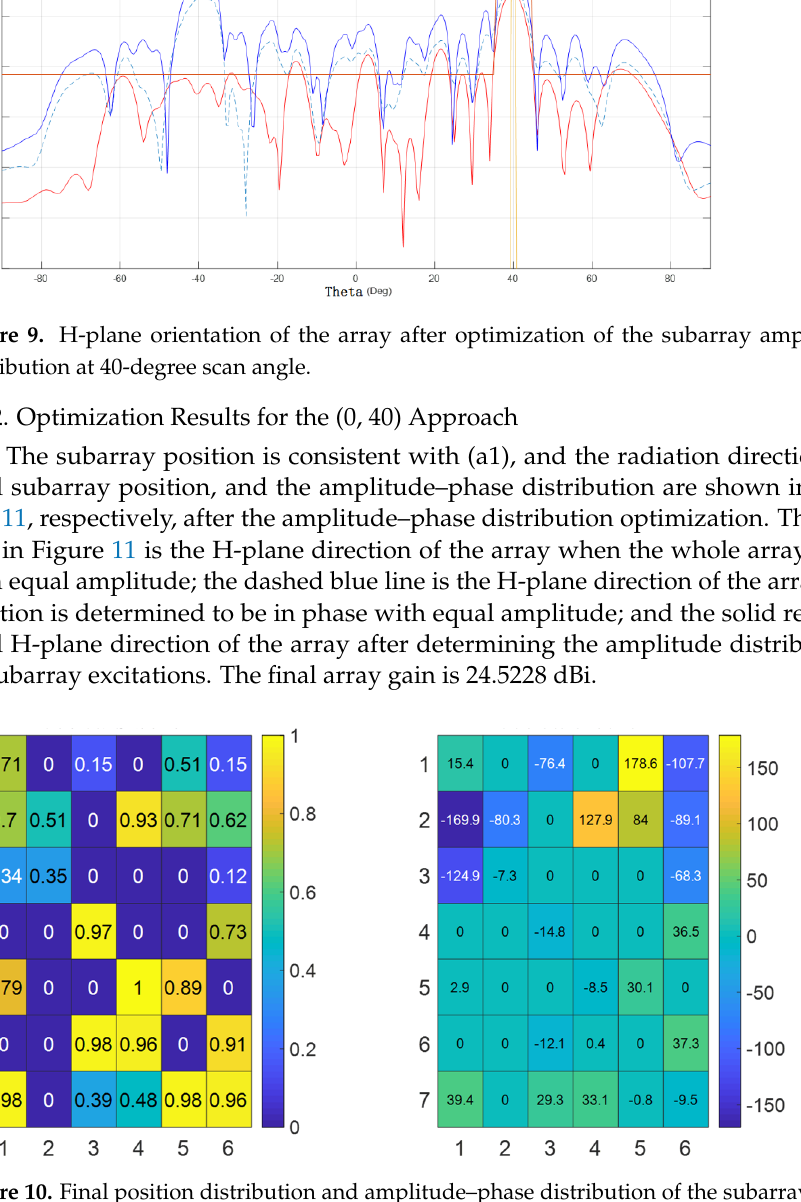
Figure 10. Final position distribution and amplitude–phase distribution of the subarray at 40-degree scan angle.